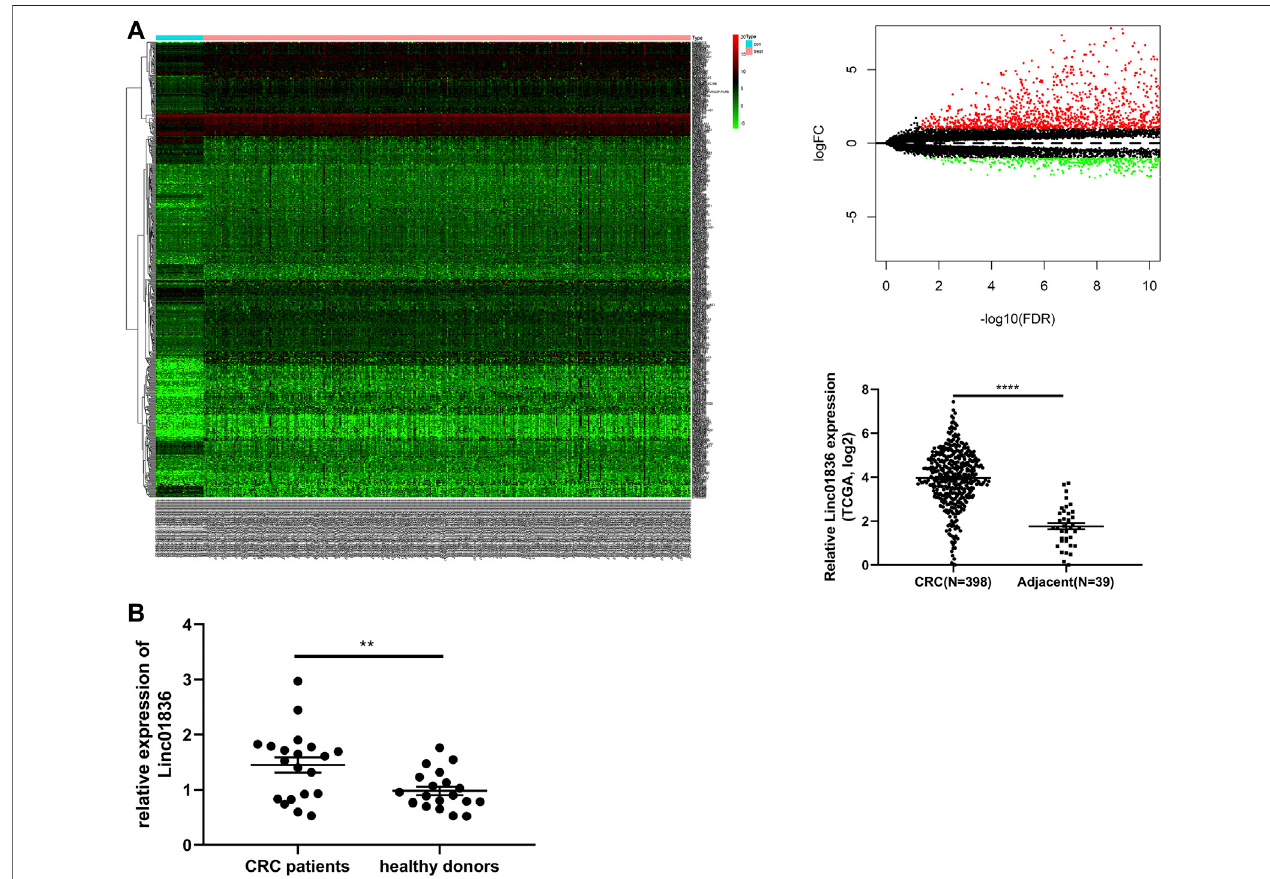
FIGURE 1 | Identi fi cation of Linc01836. (A) The dysregulated expression level of Linc01836 in The Cancer Genome Atlas (TCGA) database. (B) The expression level of serum Linc01836 in CRC patients ( n = 20) and healthy donors ( n = 20). * p < 0.05, ** p < 0.01, *** p < 0.001, **** p < 0.0001, NS p > 0.05.